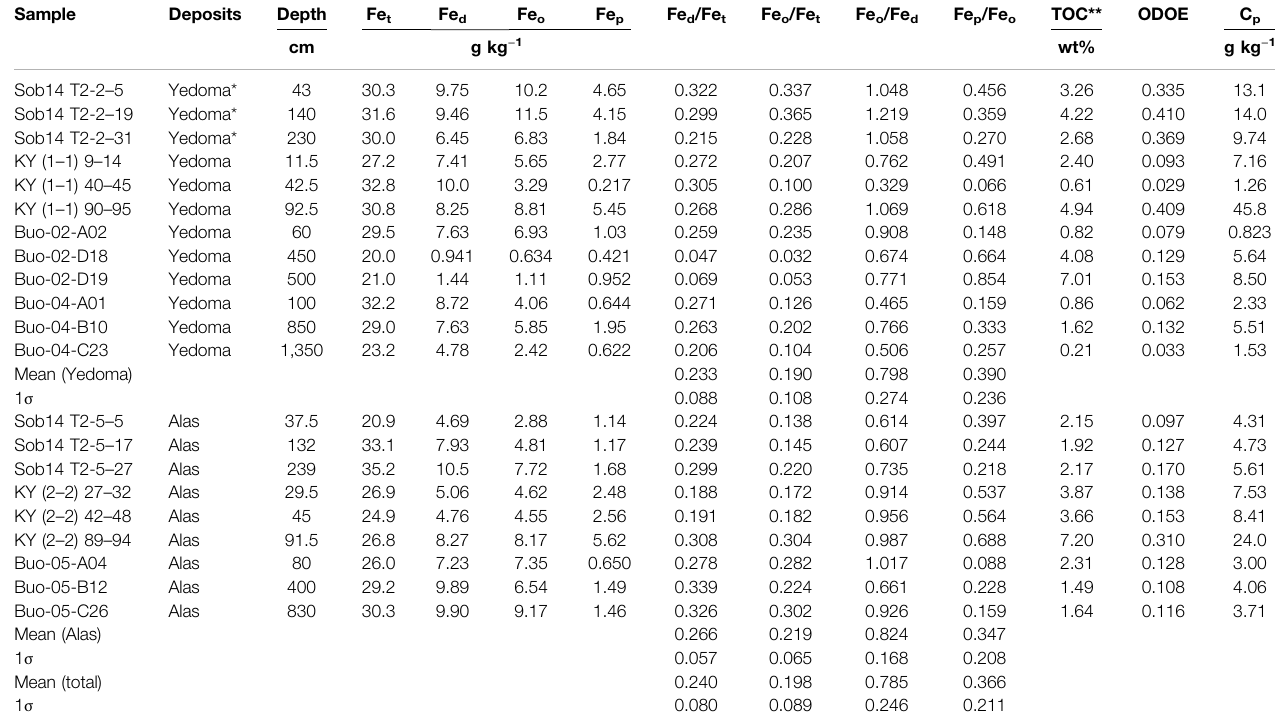
TABLE 2 | Concentrations in total Fe (Fe t ) and Fe selectively extracted by dithionite-citrate-bicarbonate (Fe d ), ammonium oxalate (Fe o ), pyrophosphate (Fe p ) in Yedoma and Alas deposits. Total organic carbon (TOC), optical density of oxalate extract (ODOE) and C extracted with pyrophosphate (C p ) are also presented. *Sobo Sise samples are Holocene age deposits on top ofYedoma Ice Complex deposits pro fi le. ** The TOC dataare from Fuchset al. (2018) for Sobo Sise Island (Sob), from Schirrmeister et al. (2017) for Buor Khaya Peninsula (Buo) and from Weiss et al. (2016) for Kytalyk (KY).